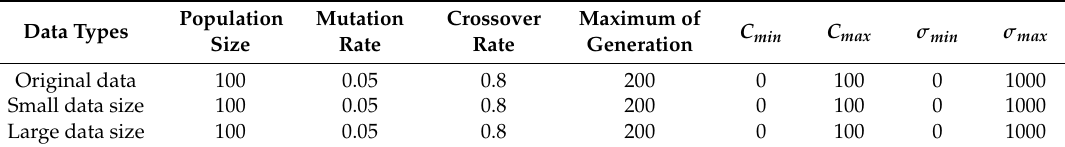
Table 3. The parameters settings of SVR-GA model for original data and Data-II (Examples 1 and 2).